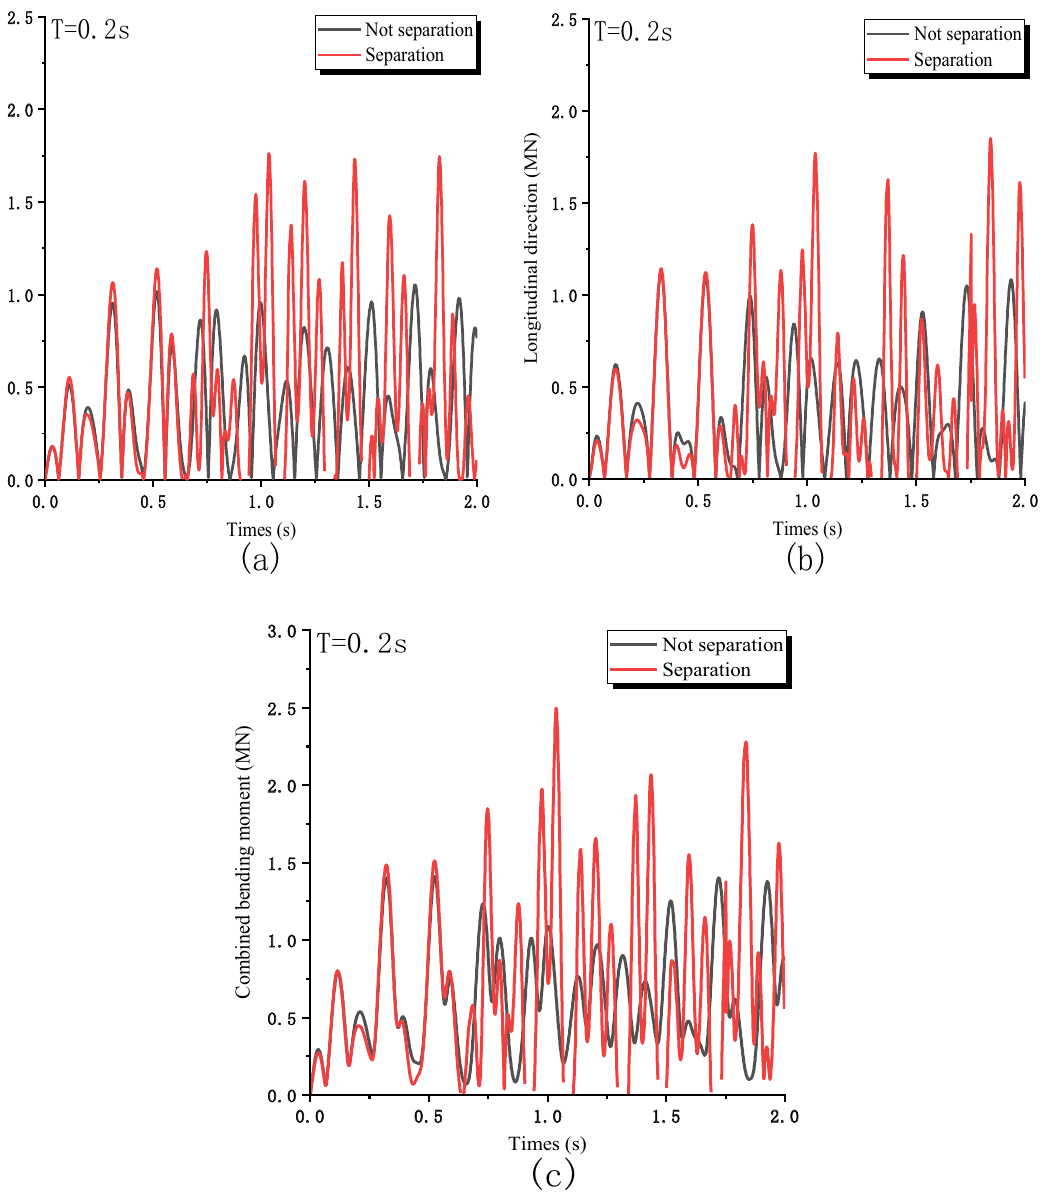
Figure 7. The bending moment generated by eccentric compression at the bottom of the pier: ( a ) Lateral direction; ( b ) Longitudinal direction; ( c ) Horizontal bending